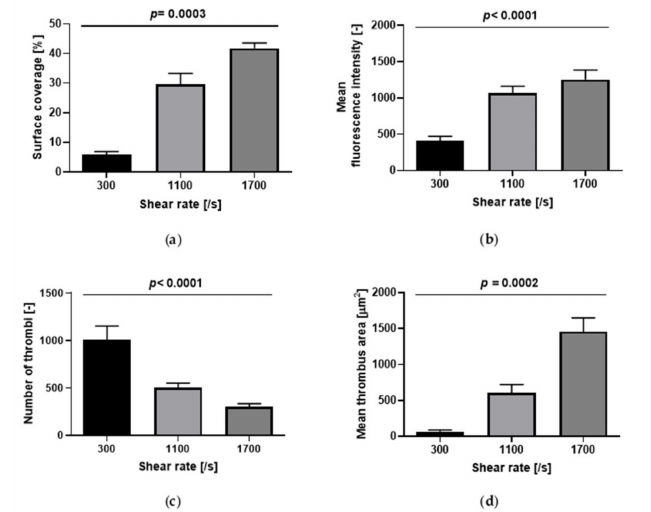
Figure3. E ff ectofwallshearrateonplateletaccumulationoncollagen(200 µ g / mL)-coatedmicrochannels ( n = 7). ( a ) Surface coverage; ( b ) mean fluorescence intensity; ( c ) number of thrombi; ( d ) mean thrombus area. Data are represented as column bar graphs, with means ± standard errors of the mean, and analyzed by Kruskal–Wallis tests or ANOVA tests as appropriate. Internal Contrasts: ( a ) 300 / s vs. 1700 / s, p < 0.001; ( b ) 300 / s vs. 1100 / s p < 0.001; 300 / s vs. 1700 / s, p < 0.001; ( c ) 300 / s vs. 1100 / s p < 0.01; 300 / s vs. 1700 / s, p < 0.001; ( d ) 300 / s vs. 1700 / s, p <